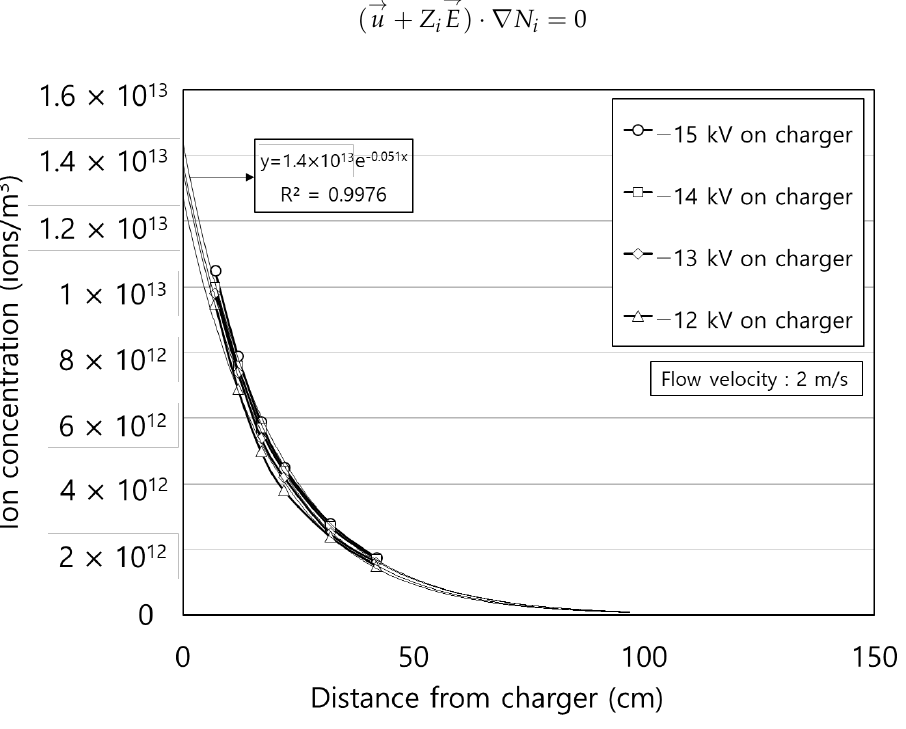
Figure 8. Ion concentration according to the distance from the